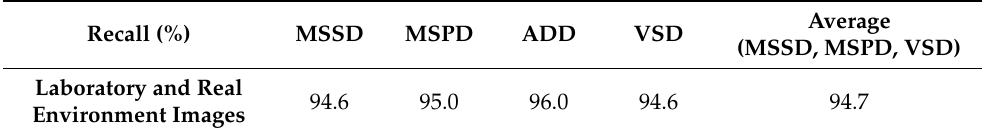
Table 3. Quantitative results for the evaluation of the object detection and localization model trained on both laboratory and real environment